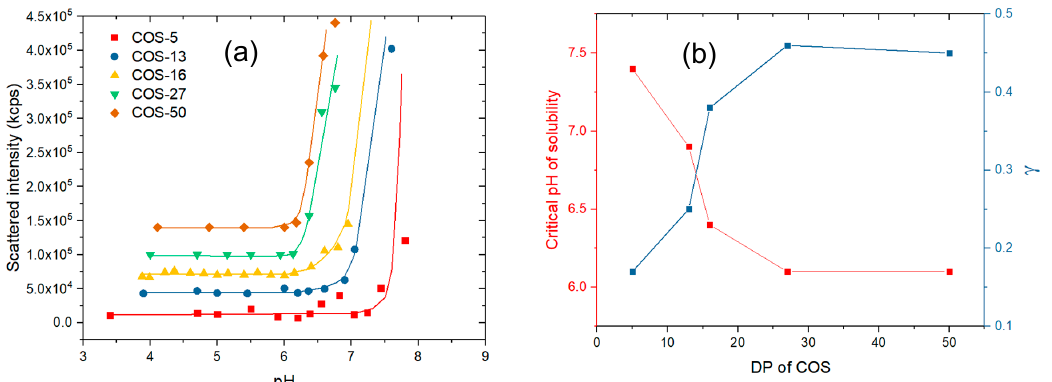
Figure 3. ( a ) The variation of the scattered light intensity (in kcps, kilo count-per-second) of COS solutions at 1 g/L as a function of the pH. The plots are shifted along the y-axis for better visibility; ( b ) the variation of the pH at the onset of the COS precipitation as a function of the DP. The corresponding values of degrees of protonation ( γ ) at the critical pH are also plotted (see Figure 2). The lines were added to guide the eye.